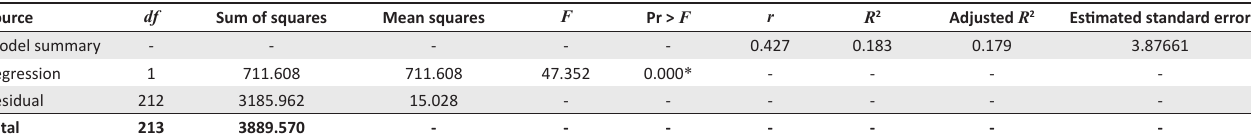
TABLE 1: Simple linear regression model fit and summary for workplace spirituality on employee mental health. Source df Sum of squares Mean squares Estimated standard error